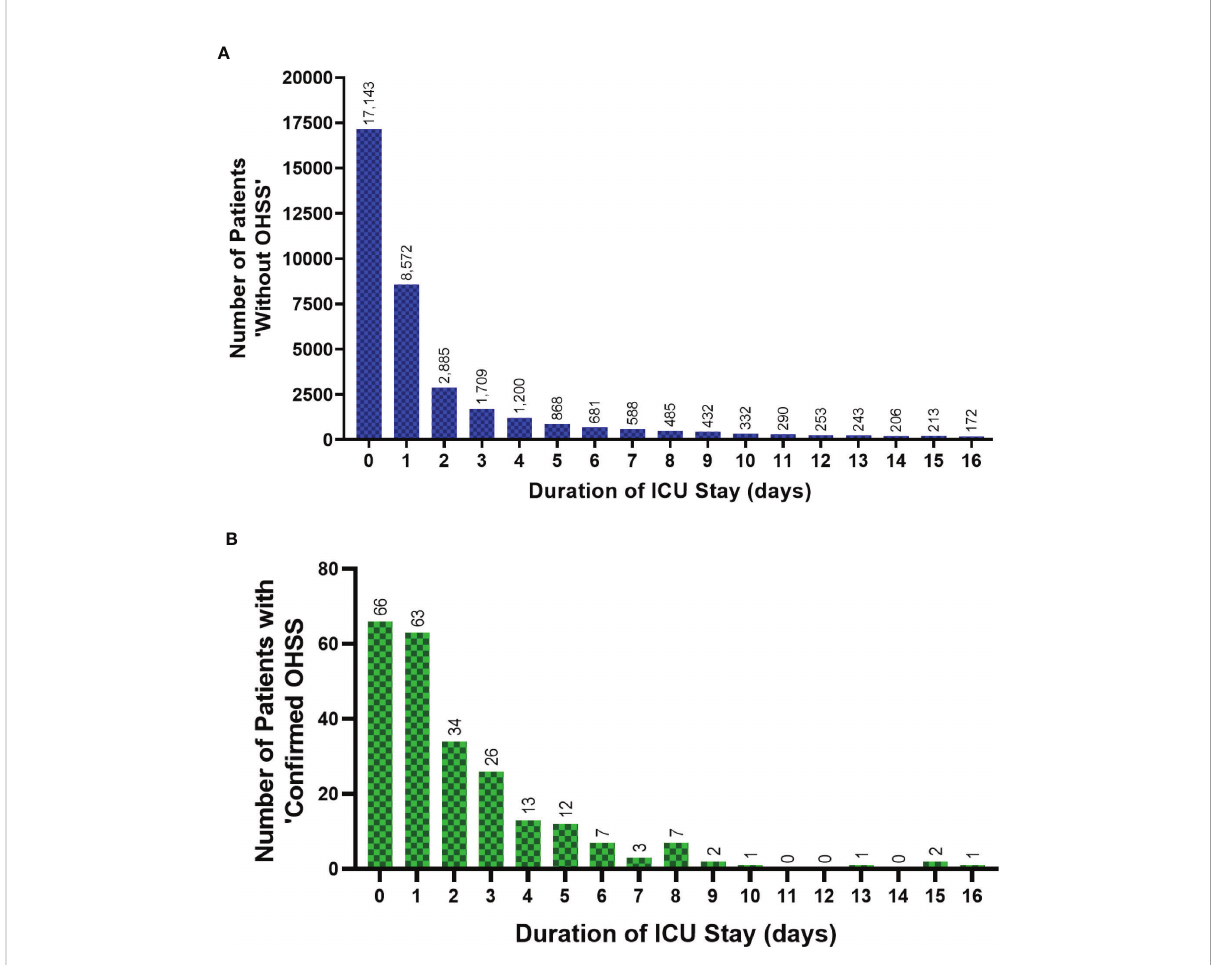
FIGURE 3 The ICU duration of stay for patients ‘ without OHSS ’ and ‘ con fi rmed OHSS ’ cases from 1996-2020. The ICU length of stay (up to 16 days) of female patients aged 18-55 years in England, Wales and Northern Ireland, 1996-Sept 2020, showing (A) patients ‘ without OHSS ’ , and (B) patients with ‘ con fi rmed OHSS ’ . Two outliers, ‘ 783 ’ and ‘ 2557 ’ days not included for two patients ‘ without OHSS ’ . Data between 17-553 days spent in ICU (n=2,331 patients) for patients ‘ without OHSS ’ has not been presented in Figure 3A to allow its direct comparison with Figure 3B. Data is presented without normalization or adjustment. Coverage of ICUs in England, Wales and Northern Ireland has increased over time and therefore, relevant historical admissions for OHSS or potential OHSS are likely to be excluded. ICU, Intensive Care Unit; OHSS, Ovarian Hyperstimulation